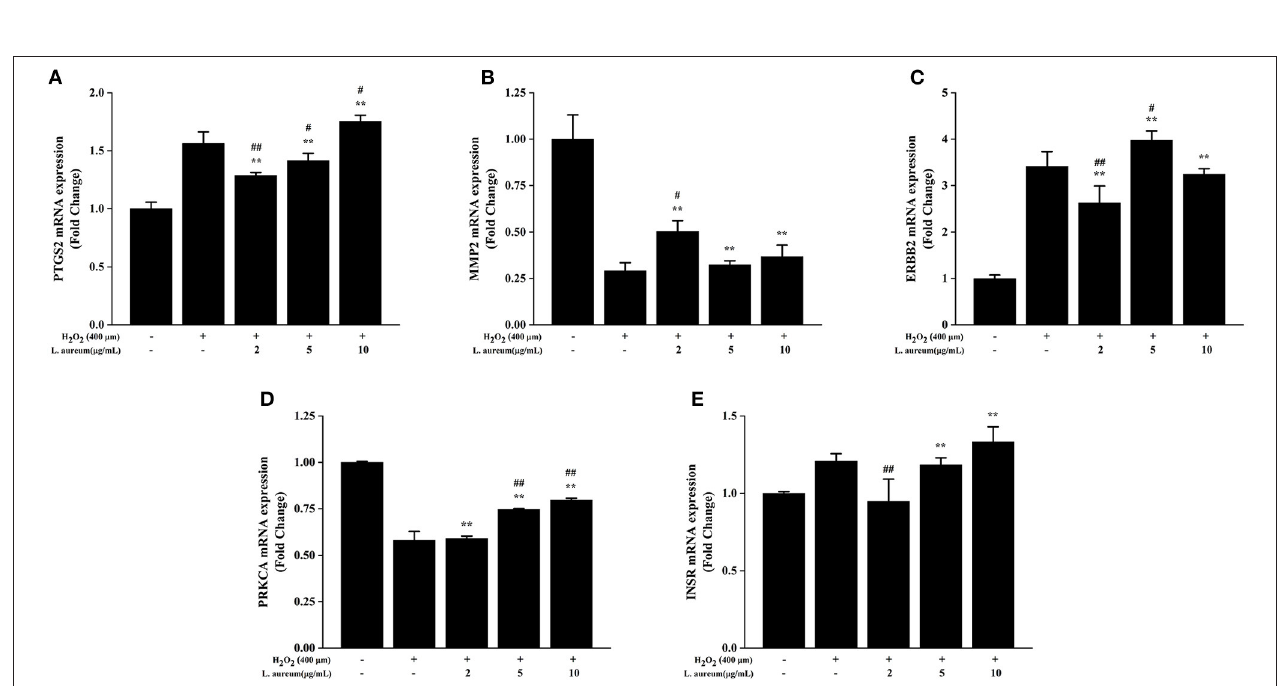
FIGURE 9 | Effects of L. aureum on expression levels of key mRNA in RAW264.7 Cells. The expression of (A) PTGS2 (COX-2), (B) MMP2, (C) ERBB2, (D) PRKCA, and (E) INSR mRNA levels were determined by qRT-PCR. The results are expressed as the mean ± SD ( n = 3). ** p < 0.01 vs. H 2 O 2 -untreated group, # p < 0.05 and ## p < 0.01 vs. H 2 O 2 group were considered statistically significant